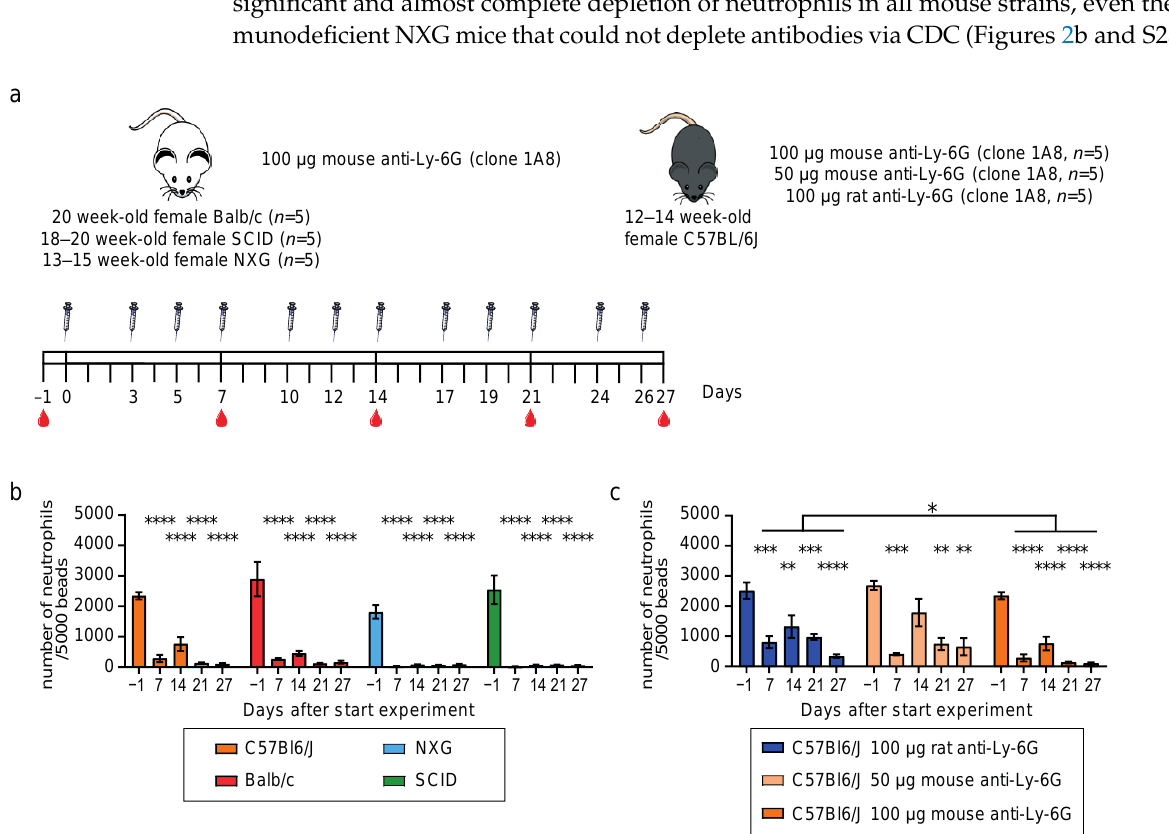
Figure 1. Mouse-Ly-6G efficiently depletes neutrophils in old C57Bl6/J mice. ( a ) Experimental set- up; i.p. injections with the depletion-antibodies or vehicle control (PBS) were performed three times a week for four weeks. Blood was drawn via cheek puncture before injection with the antibodies; ( b ) FACS dot plots of a representative PBS-treated mouse, showing the gating strategy to retrieve the number of neutrophils per 5000 beads. First, the latex beads and CD45 + cells were selected. From the CD45 + population, Siglec-F and CD115 positive cells were excluded. Based on SSC/FSC profile, the neutrophils were selected and purity was confirmed using Gr-1 and CD11b positivity; ( c – e ) Longitudinal analysis of the number of CD45 + Siglec-F - CD115 - SSC high Gr-1 + CD11b + neutrophils per 5000 beads in the peripheral blood ( n = four mice per subgroup) showing ( c ) inefficient depletion with 50 μ g rat-Ly-6G antibody; ( d ) efficient short-term depletion with 25 μ g mouse-Ly-6G spanning the first week, and ( e ) efficient long-term depletion with 100 μ g mouse-Ly-6G. Data is presented as mean with standard error of the mean (SEM). Statistics: one-way ANOVA with Bonferroni correction, * = p < 0.05, ** = p < 0.01, *** = p < 0.001, **** = p < 0.0001.